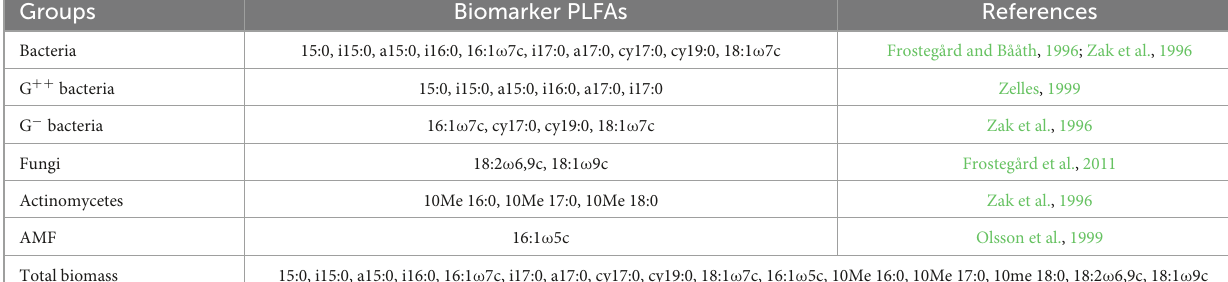
TABLE A2 Signatures and biomarkers of selected phospholipid fatty acids (PLFAs) used in this study.